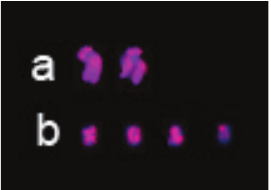
Figure 4. FISH patterns of B chromosomes detected by pAs1 (red). a submetacentric B chromosomes in A. mongolicum b metacentric B chromosomes in A.